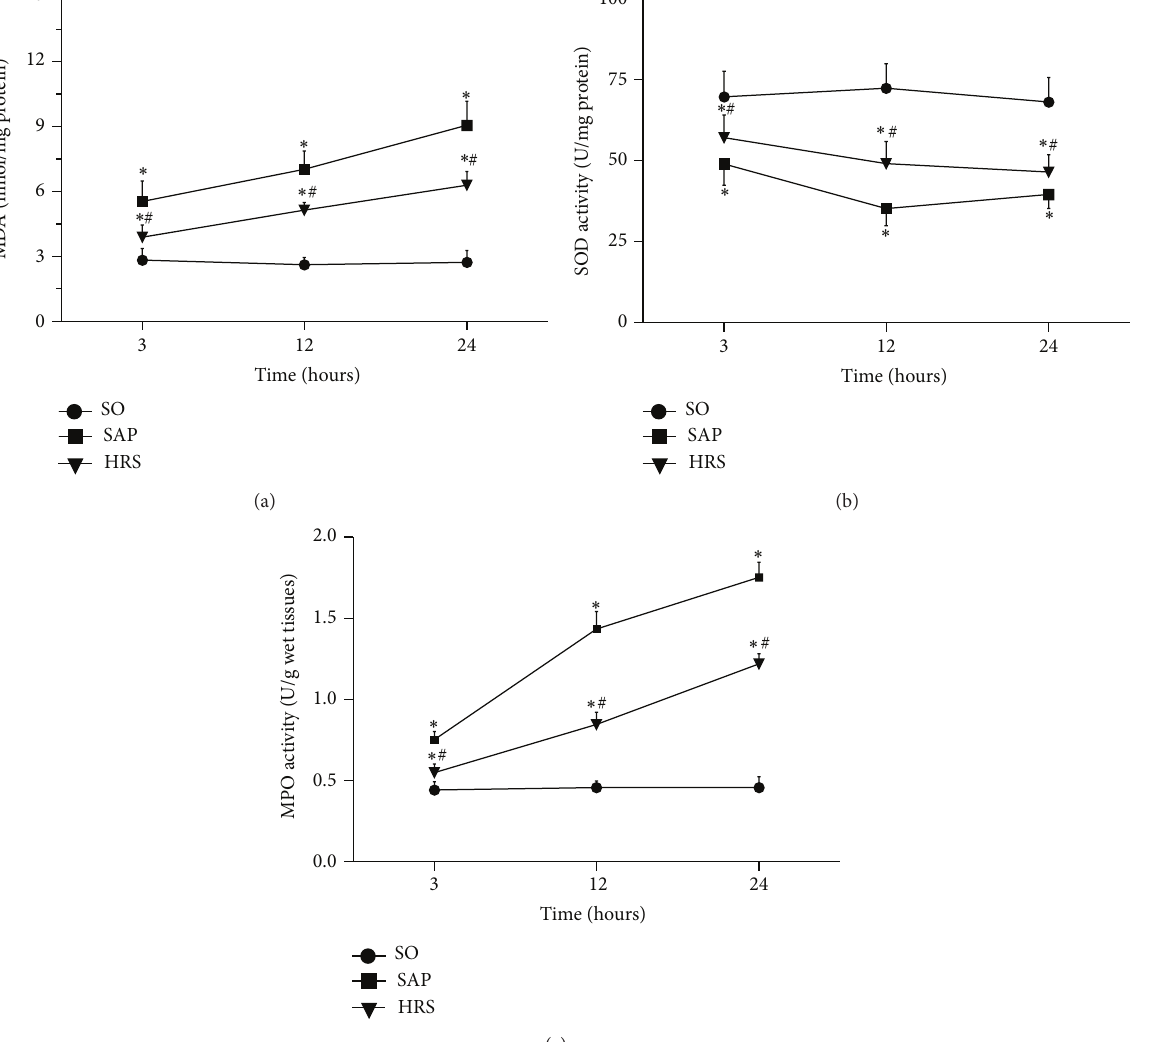
Figure 4: Effects of hydrogen-rich saline reduced oxidative stress and renal neutrophil infiltration in renal tissues. (a) Content of MDA, (b) SOD activity, and (c) MPO activity. Results are expressed as mean (SD), 8 rats per group. ∗ 𝑃 < 0.05 versus respective SO group; # 𝑃 < 0.05 versus respective SAP